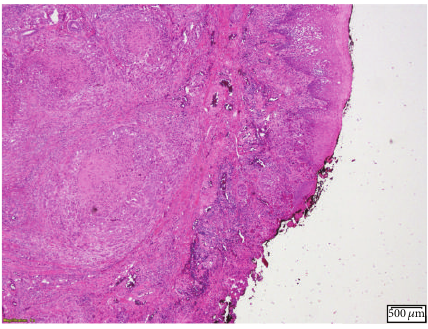
Figure 2: H&E stain showing poorly differentiated adenocarci-